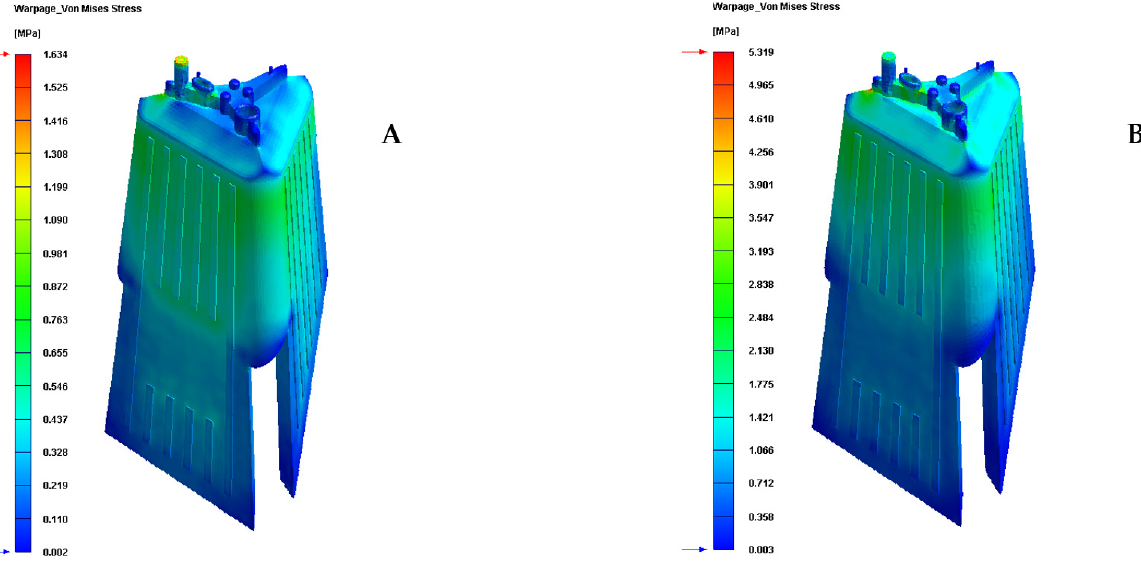
Figure 17. Warpage Von—Mises stress (MPa). ( A ) New conformal cooling system and Fastcool insert. ( B ) Traditional cooling.